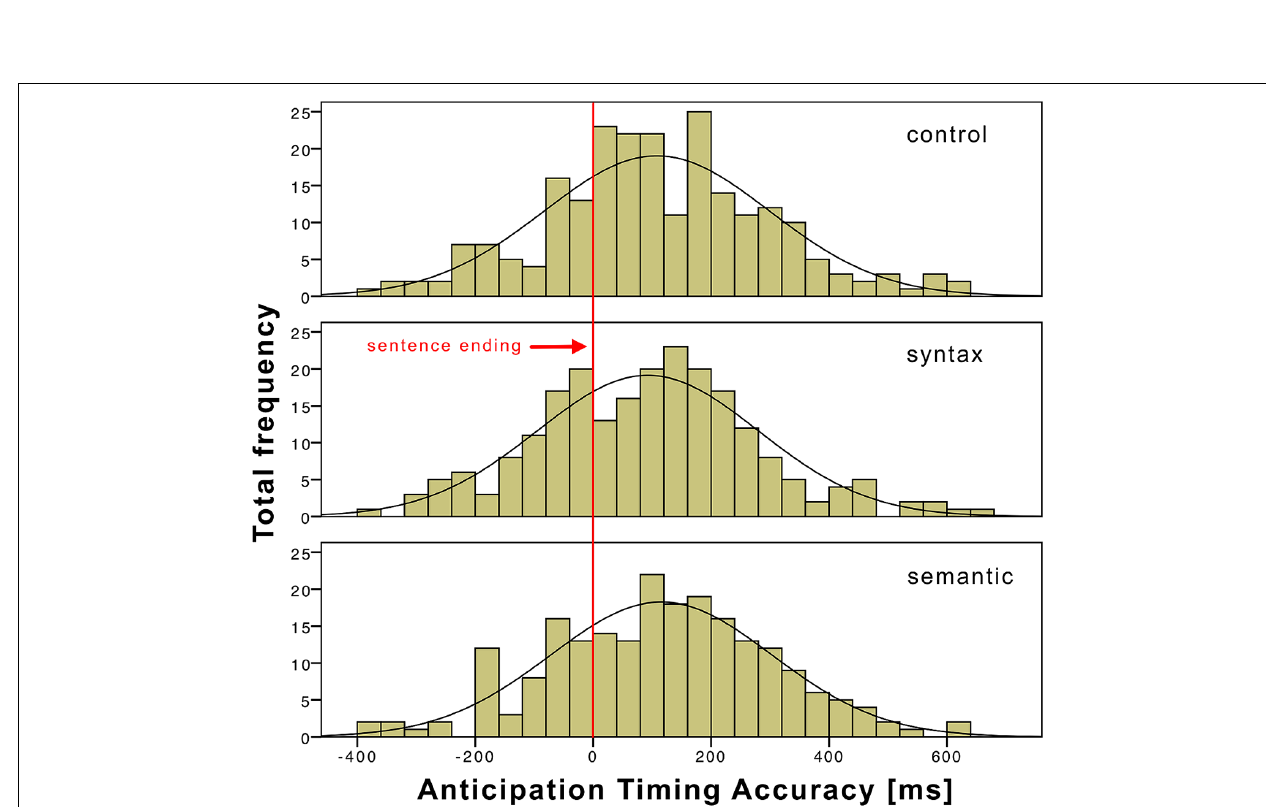
FIGURE 2 |ATA histogram of the three conditions time-locked (0) to the sentence end and with a bin width of 40 ms.